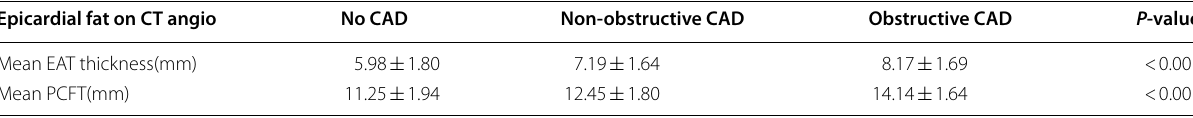
CAD , coronary artery disease; EAT , epicardial adipose tissue; PCFT , pericoronary fat thickness